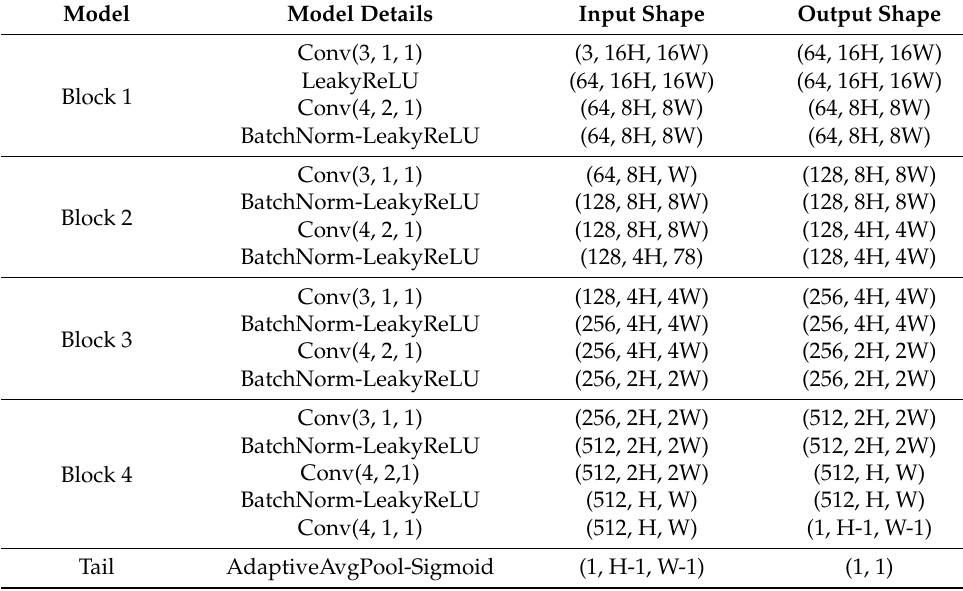
Table 2. The network architecture configuration of the